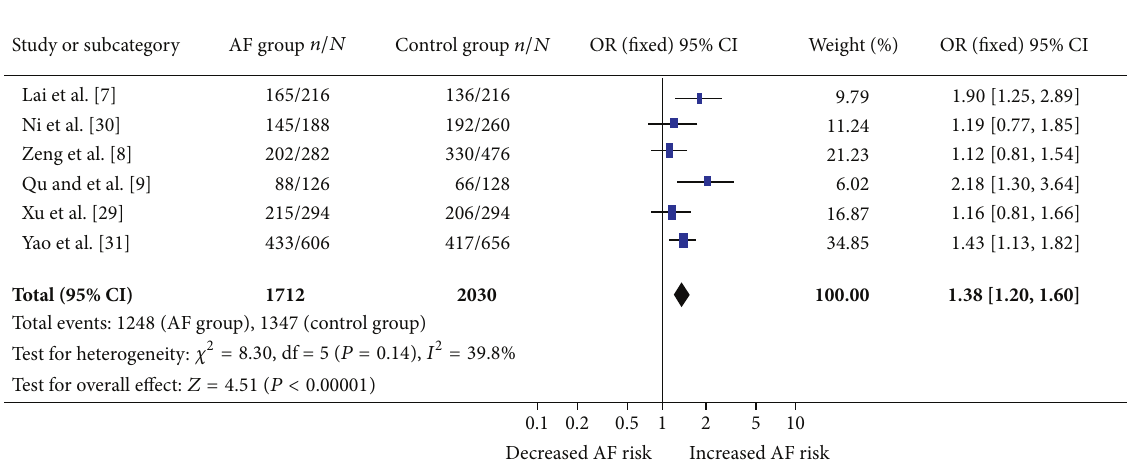
Figure 1: Forest plot of AF associated with Mink S38G gene polymorphism under an allelic genetic model (distribution of G allelic frequency of Mink S38G gene polymorphism) in the Chinese